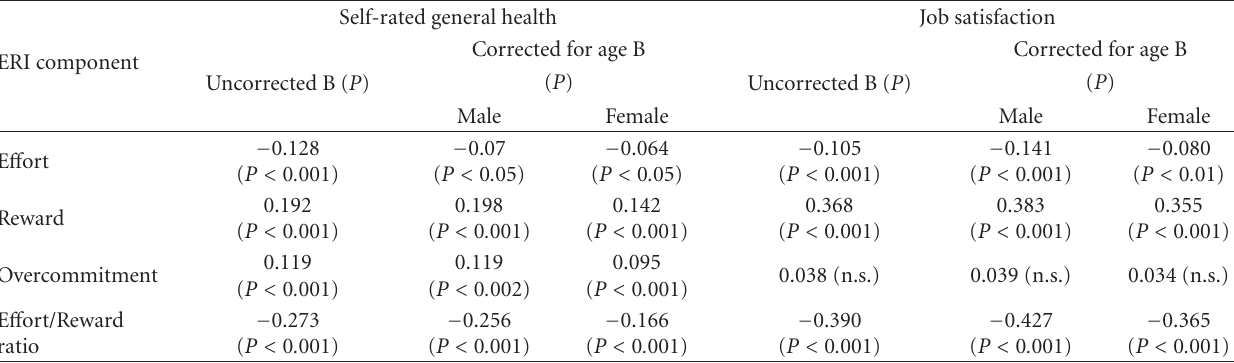
Table 3: Associations of the scales of the short e ff ort-reward imbalance questionnaire with self-rated general health and job satisfaction (multiple regression